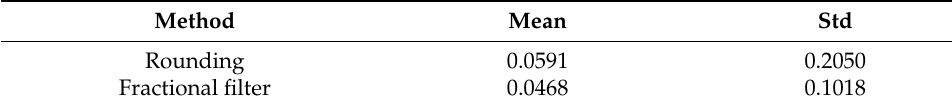
Figure 7. Histogram of additional errors caused by rounding. Table 1. Mean and standard deviation of additional